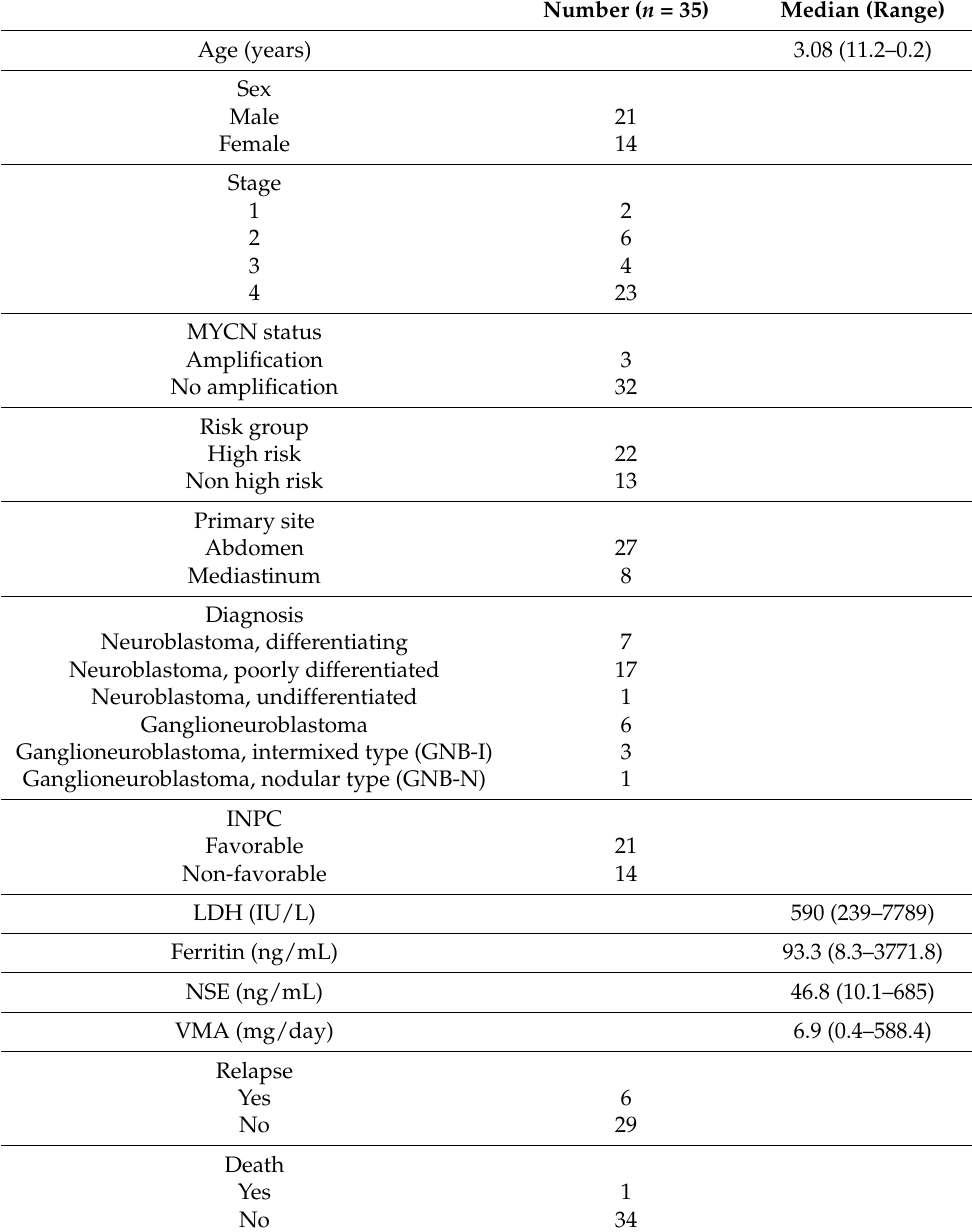
Table 1. Summarization of the clinicopathologic information in patients of